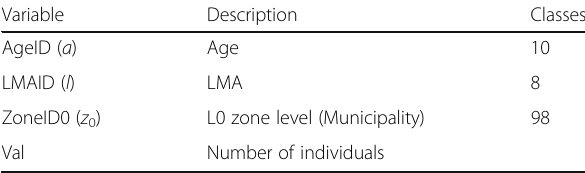
Table 6 Target T ai ( z 0, a , l ) for age, LMA and municipality